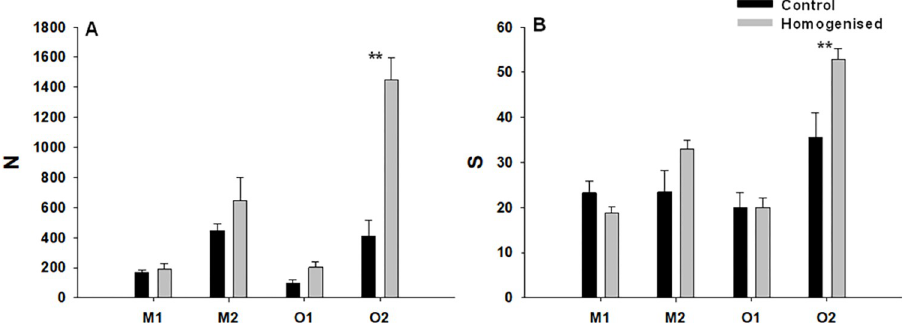
Fig 2. Abundance and richness of macrofauna associated with Mytilus galloprovincialis . Mean values (+SE) of total number of individuals (A) and total number of taxa (B). Asterisk indicates significant differences (SNK test, �� : p <